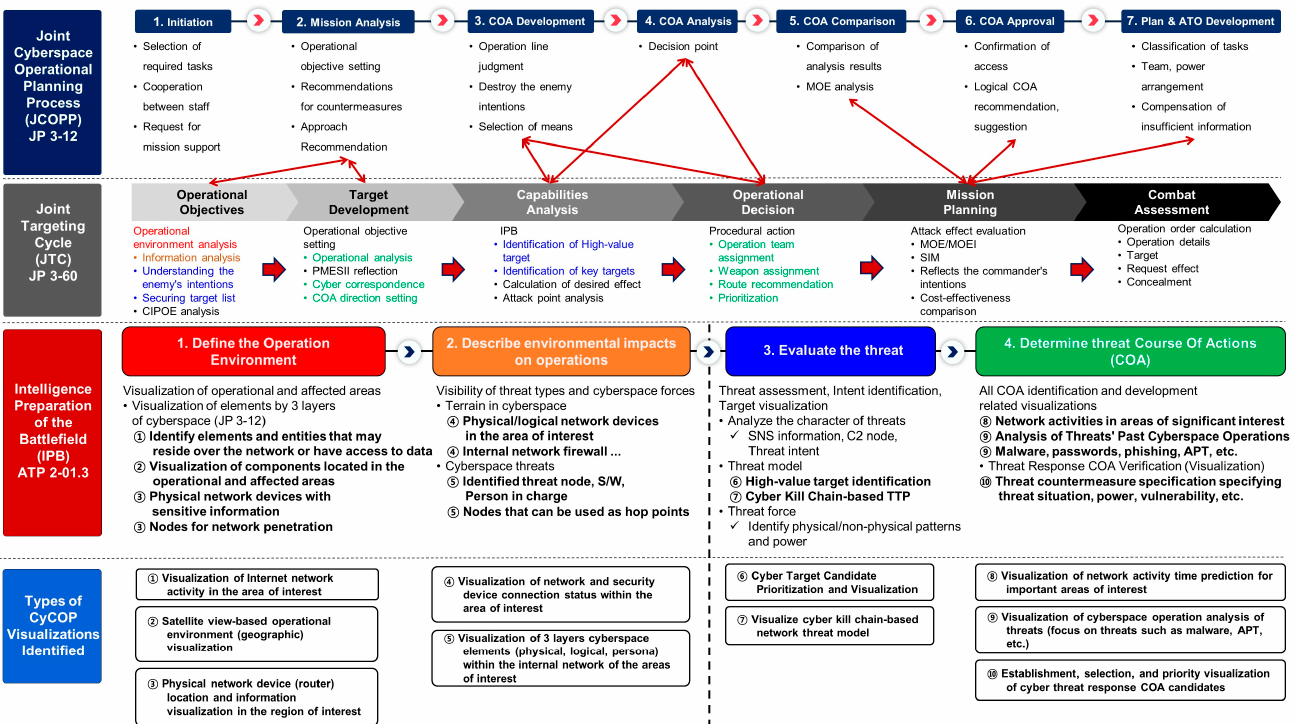
Figure 1. Joint Cyberspace Operational Planning Process based on Joint Publication 3–12.